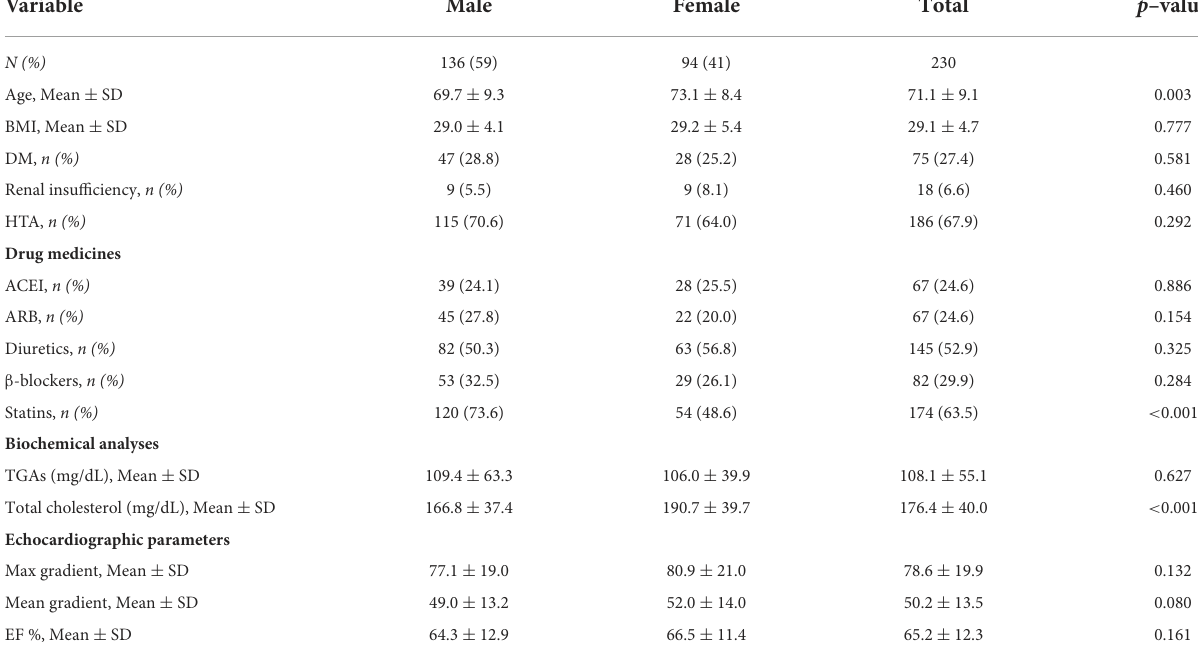
TABLE 1 Clinical and demographical data of AS patients. Variable